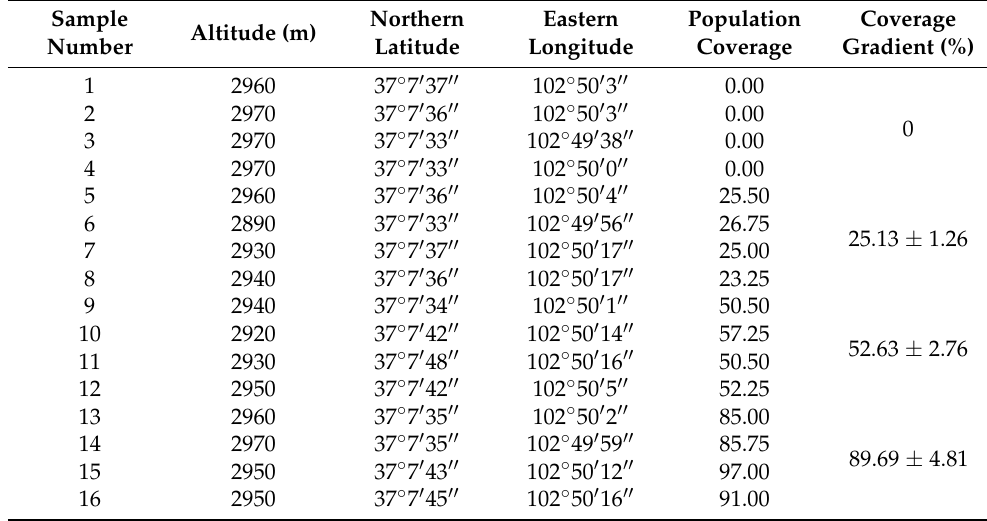
Table 1. Sample plot information